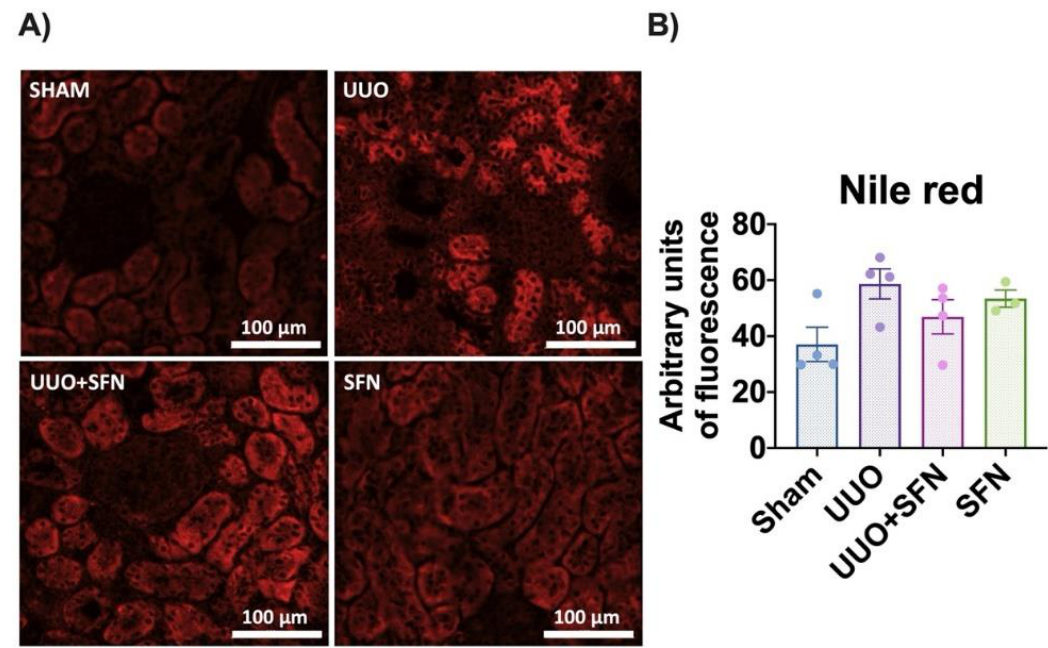
Figure 8. Effect of sulforaphane (SFN) on lipid deposition in the unilateral ureteral obstruction (UUO) model. ( A ) Representative micrographs of Nile red staining and ( B ) quantification of Nile red stain. The Nile red staining showed a higher lipid deposition in the unilateral ureteral obstruction (UUO) group than in the sham group, while SFN decreased lipids in the UUO + SFN group. n = 4 for sham, UUO, and UUO + SFN and n = 3 for SFN. Data were analyzed using a one-way ANOVA, and statistical differences were determined with multiple comparisons using Tukey’s test. Sham: simulated surgery without ligation of the ureter; UUO: unilateral ureteral obstruction with double ligation of the left ureter for seven days; UUO + SFN: UUO treated with SFN (1 mg/kg, intraperitoneal); and SFN: administered with SFN (1 mg/kg,